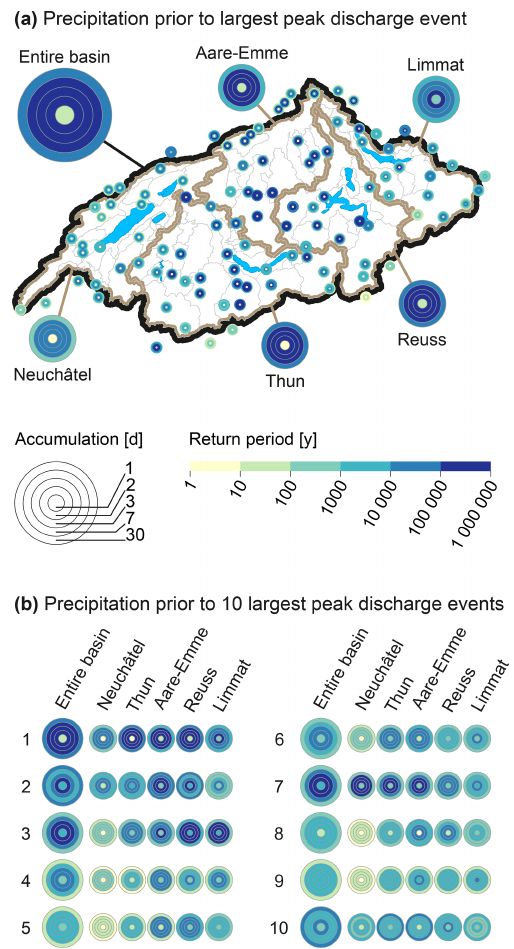
Figure 10. Return periods of precipitation over different accumula- tion durations (in days before occurrence of peak discharge at the Aare River outlet), shown for all sites considered (only for largest hydrological event in panel a ) as well as for different spatial aggre- gations (sub-regions and entire basin) for the 10 biggest peak flow events simulated at the outlet of the Aare River basin (panel b